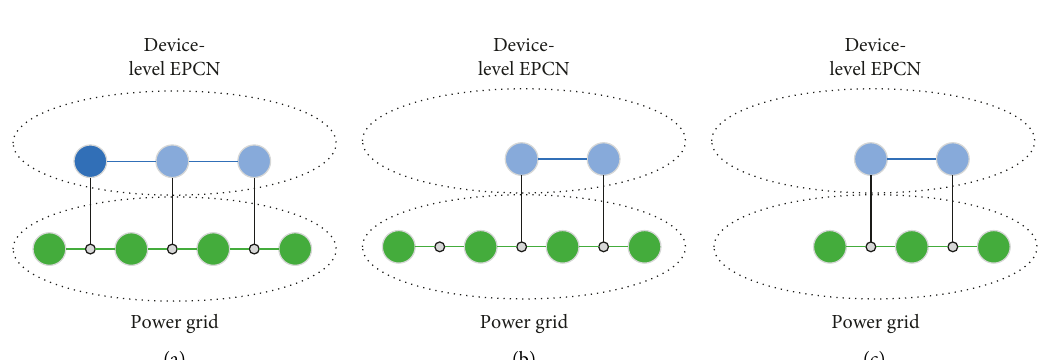
Figure 3: Cascading process of cyber node failure.